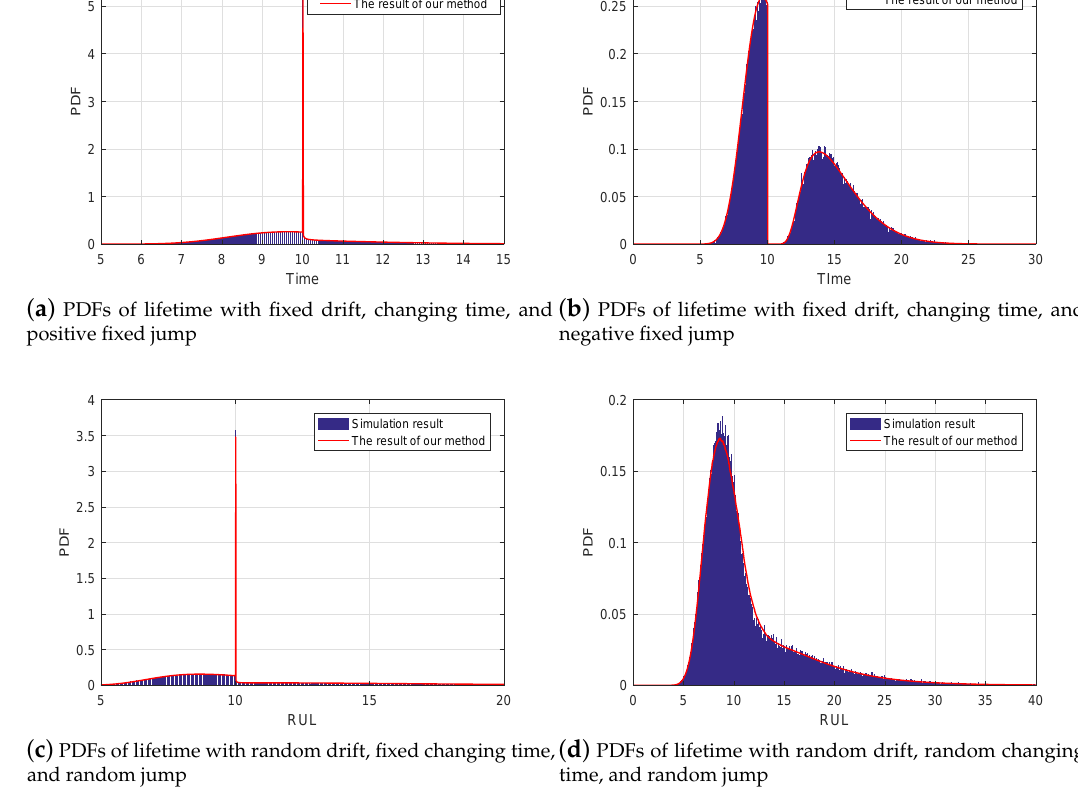
Figure 2. The estimated lifetime PDFs under different conditions.